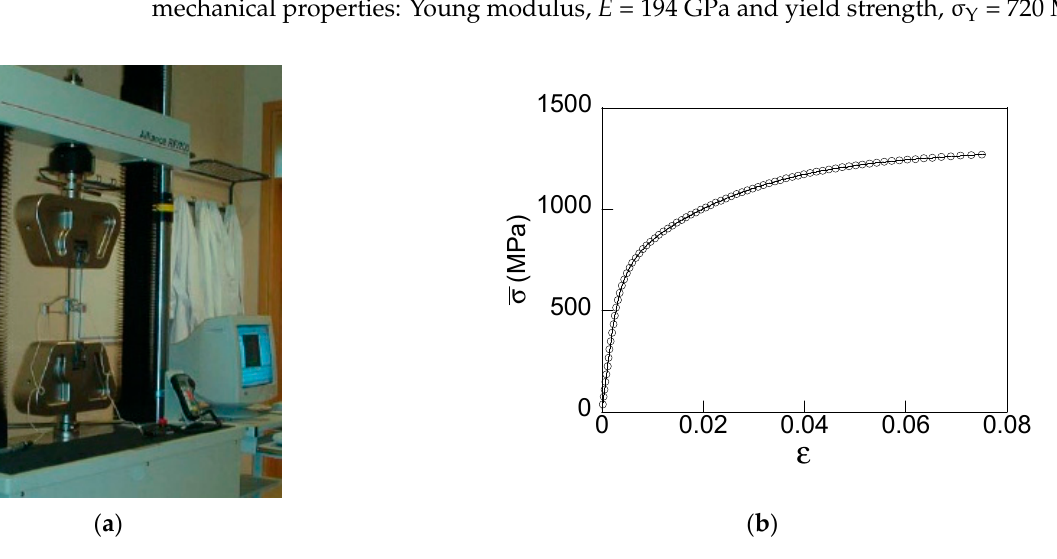
Figure 2. Conventional tension test: ( a ) experimental set-up and ( b ) experimental stress–strain curve of the raw material before cold drawing.